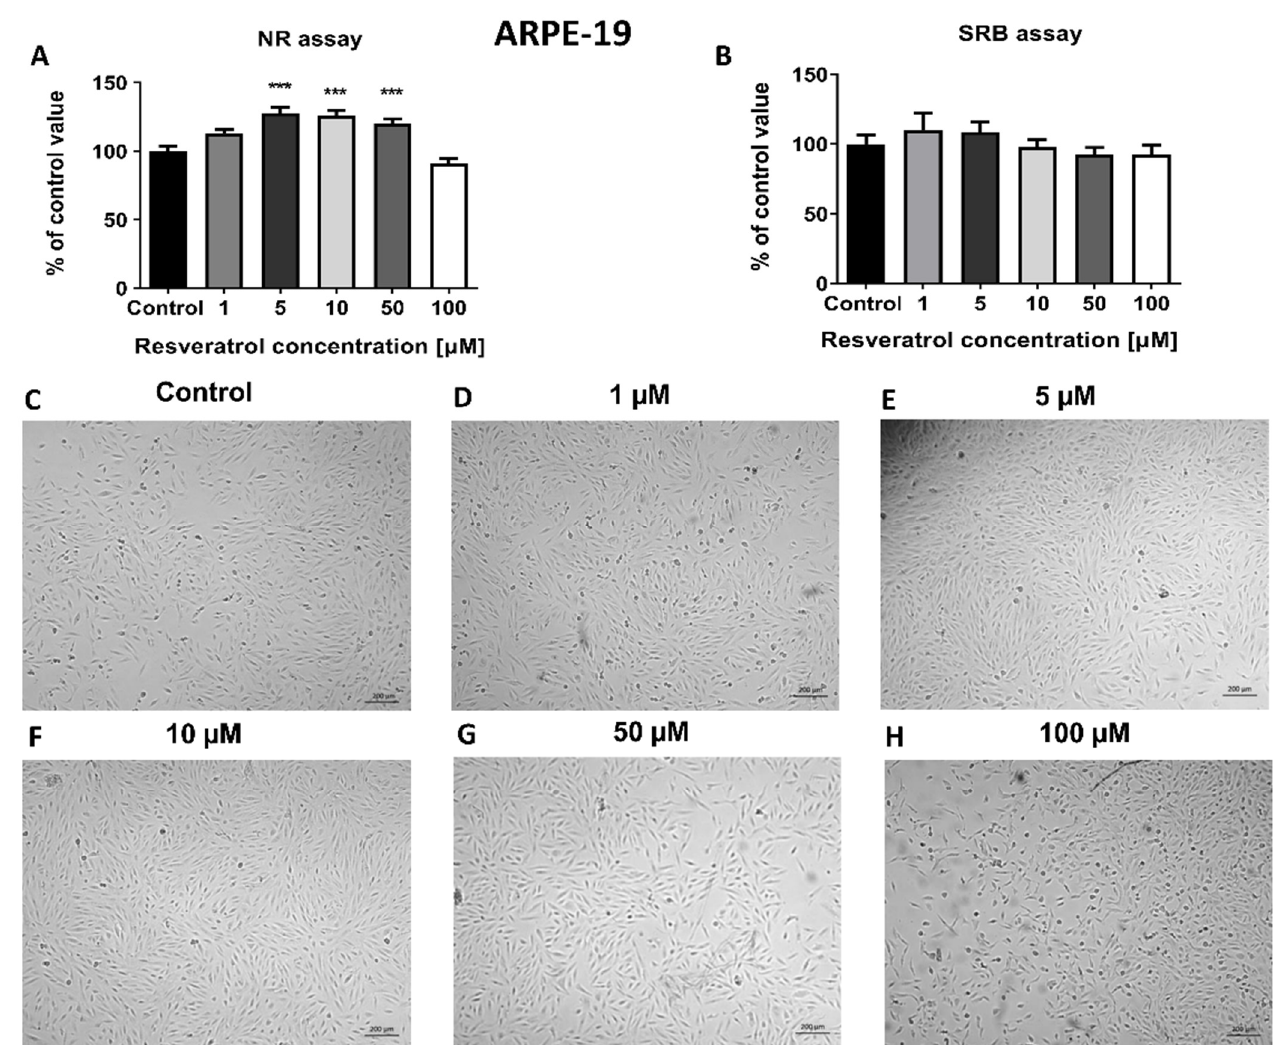
Figure 2. Effect of different RSV concentrations on ARPE-19 cell proliferation as analysed by ( A ) NR assay and ( B ) SRB assay. Cell were incubated for 24 h with RSV (1, 5, 10, 50, 100 µM). Control cells were cultured with 0.1% DMSO and without RSV. ( C – H ) Light microscopy images of control and RSV-treated cells (Delta Optical, magnification 100×). The results are presented as mean ± SD at least of three experiments with *** p < 0.001 compared to control.